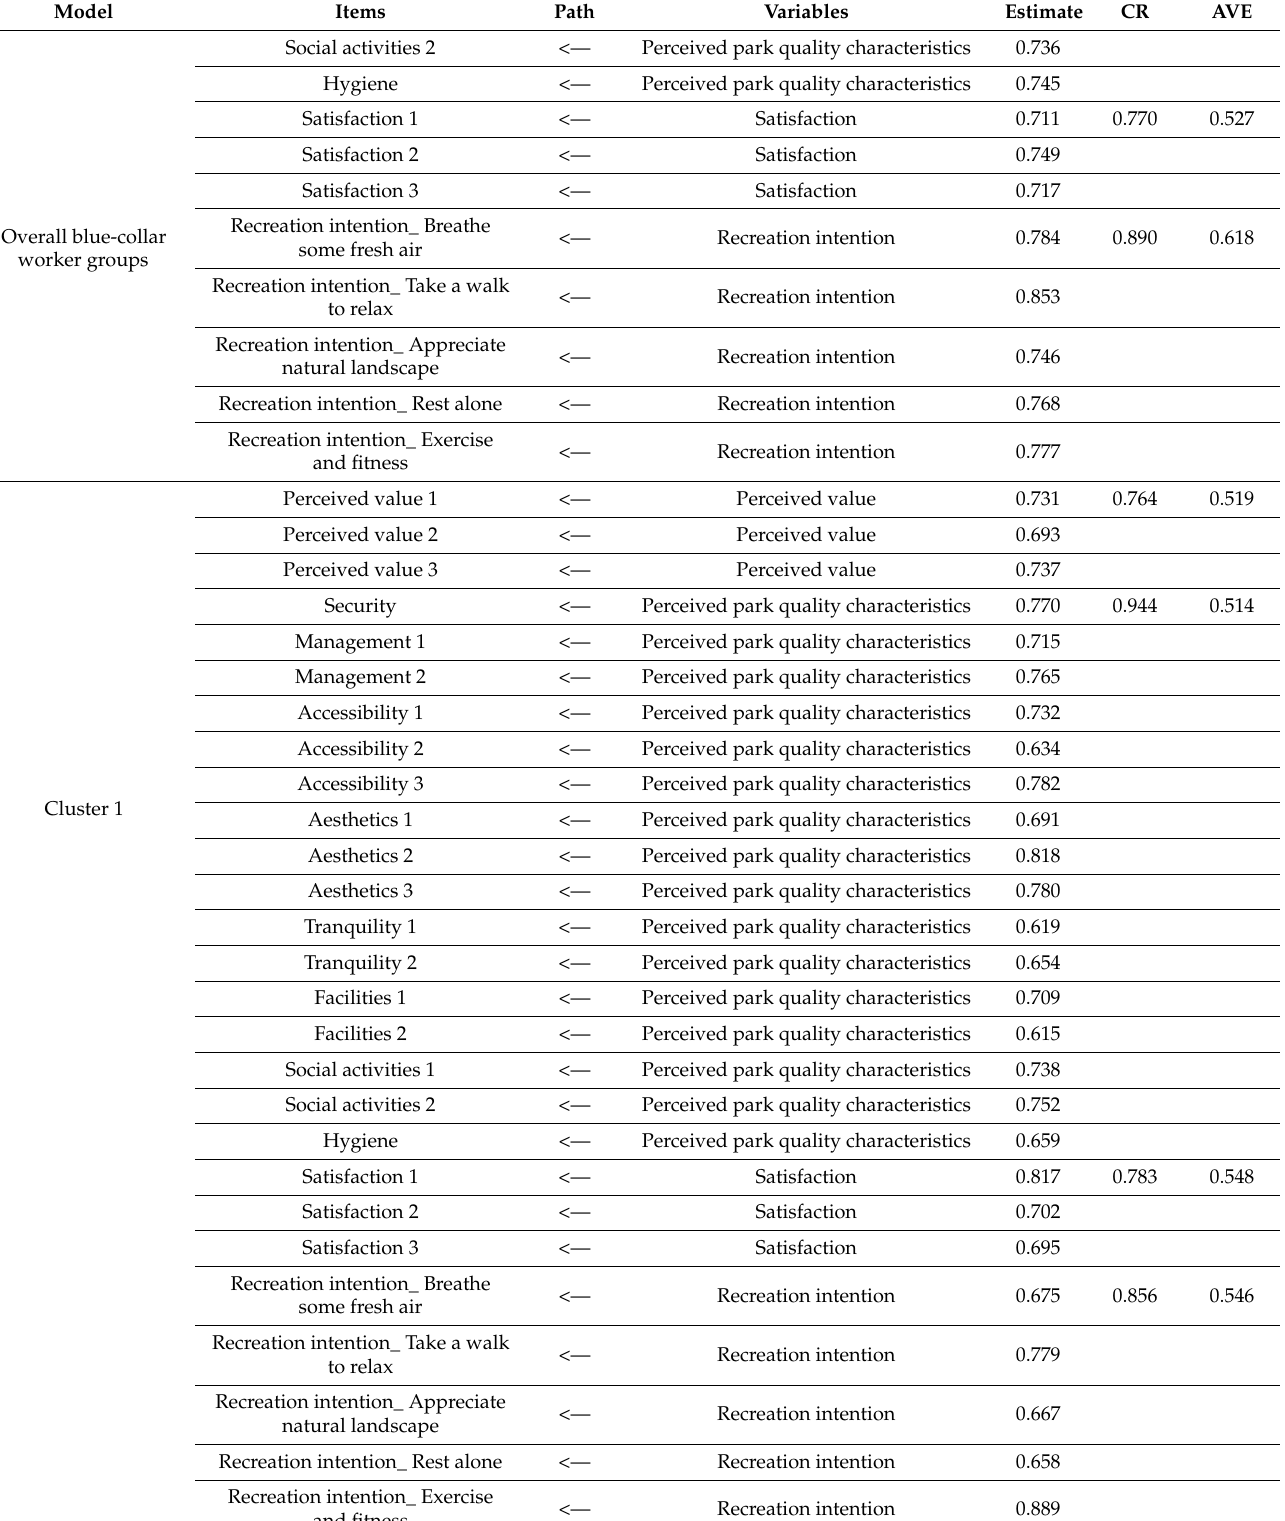
Table A5. Reliability and validity analysis by AMOS. Model Items Path AVE